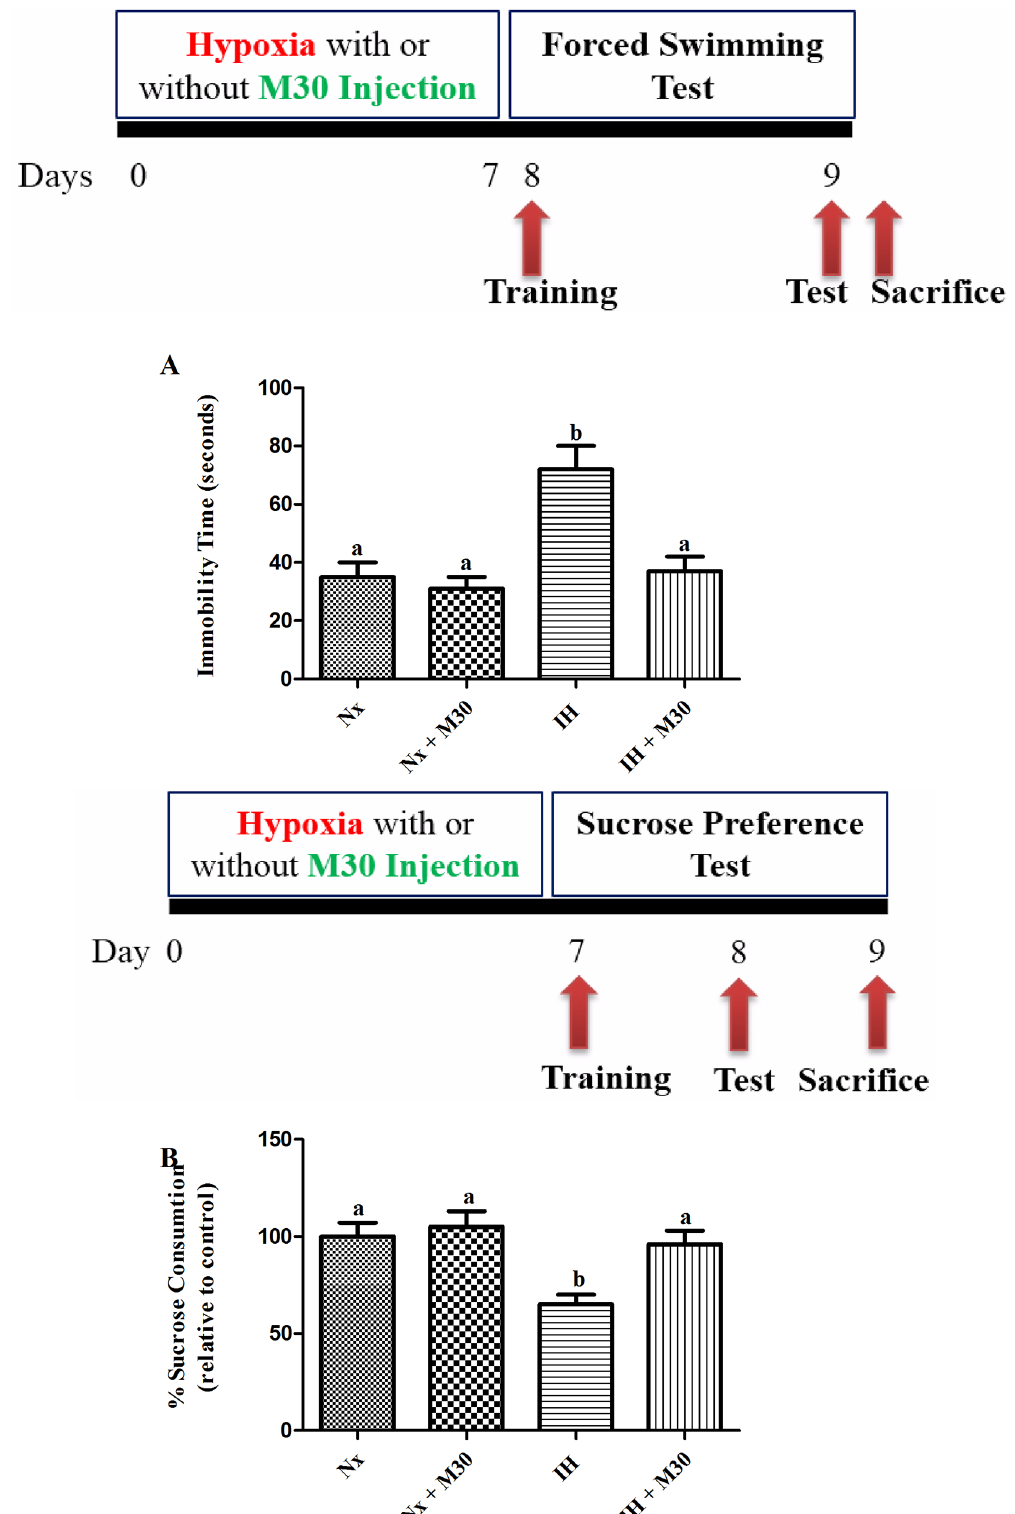
Fig 1. Hypoxia induced depressive-like behavior in the rat, which was significantly prevented by the M30 administration. Panels A and B represent the immobilitytime and percentage of sucrose consumption of the rats in